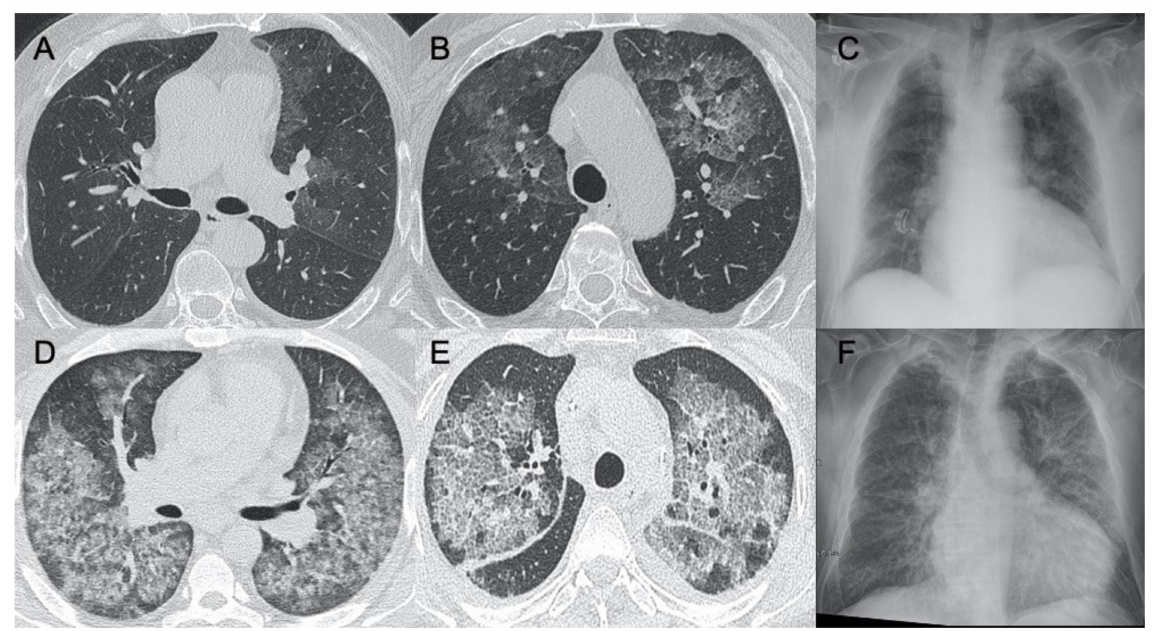
Figure 8. Cytomegalovirus pneumonia. Images in ( A – C ) show a case of mild parenchymal involvement on CMV pneumonia. Figures ( D , E ) show a patient with diffuse ground-glass opacities with a crazy-paving appearance, visible also in the chest radiograph ( F